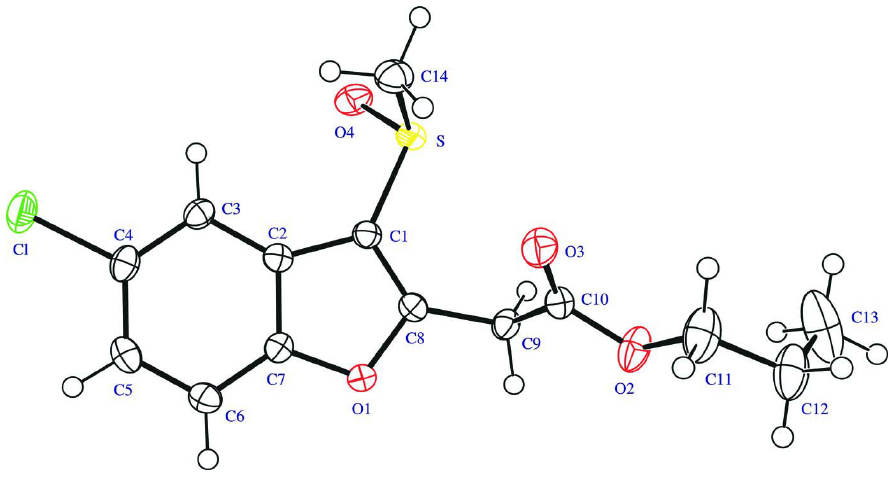
Figure 1 The molecular structure of the title compound, showing displacement ellipsoids drawn at the 50% probability level.